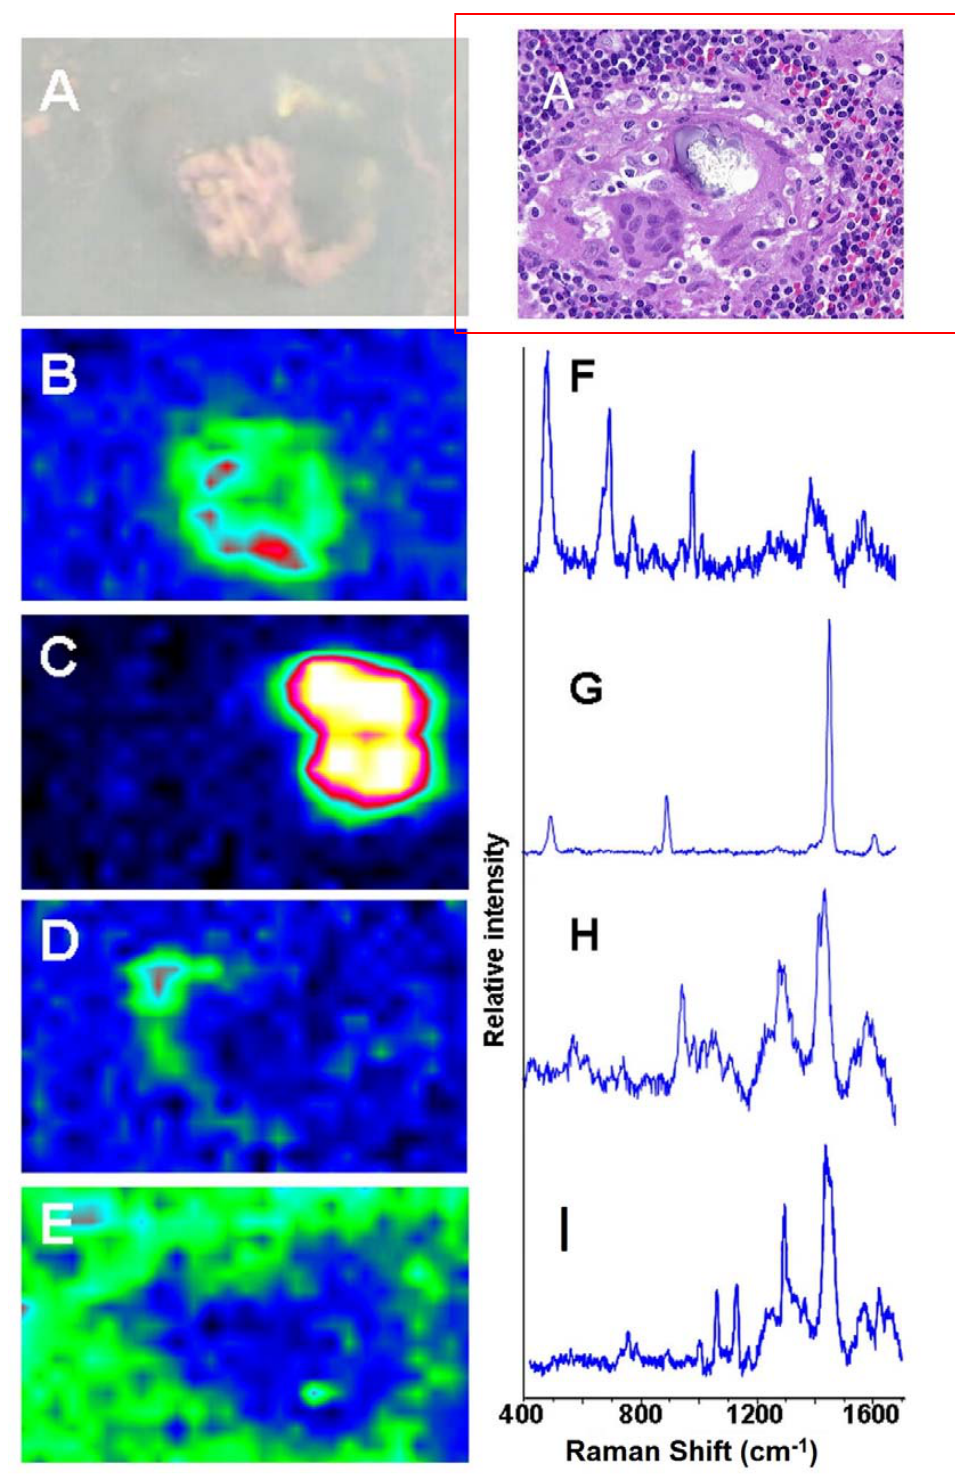
Figure 4. Raman spectroscopy generated images of silicone migrated to axillary lymph node: ( A ) white light and HE image; ( B ) Raman generated image based on the distribution of silicone shown in spectrum ( F ); ( C ) Raman image based on distribution of oxalate shown in spectrum ( G ); ( D ) Raman image based on the distribution of phosphate shown in spectrum ( H ); ( E ) Raman image of tissue around the migrated silicone; ( I ) Raman spectrum from the tissue surrounding the phenyl silicone and Schaumann body.